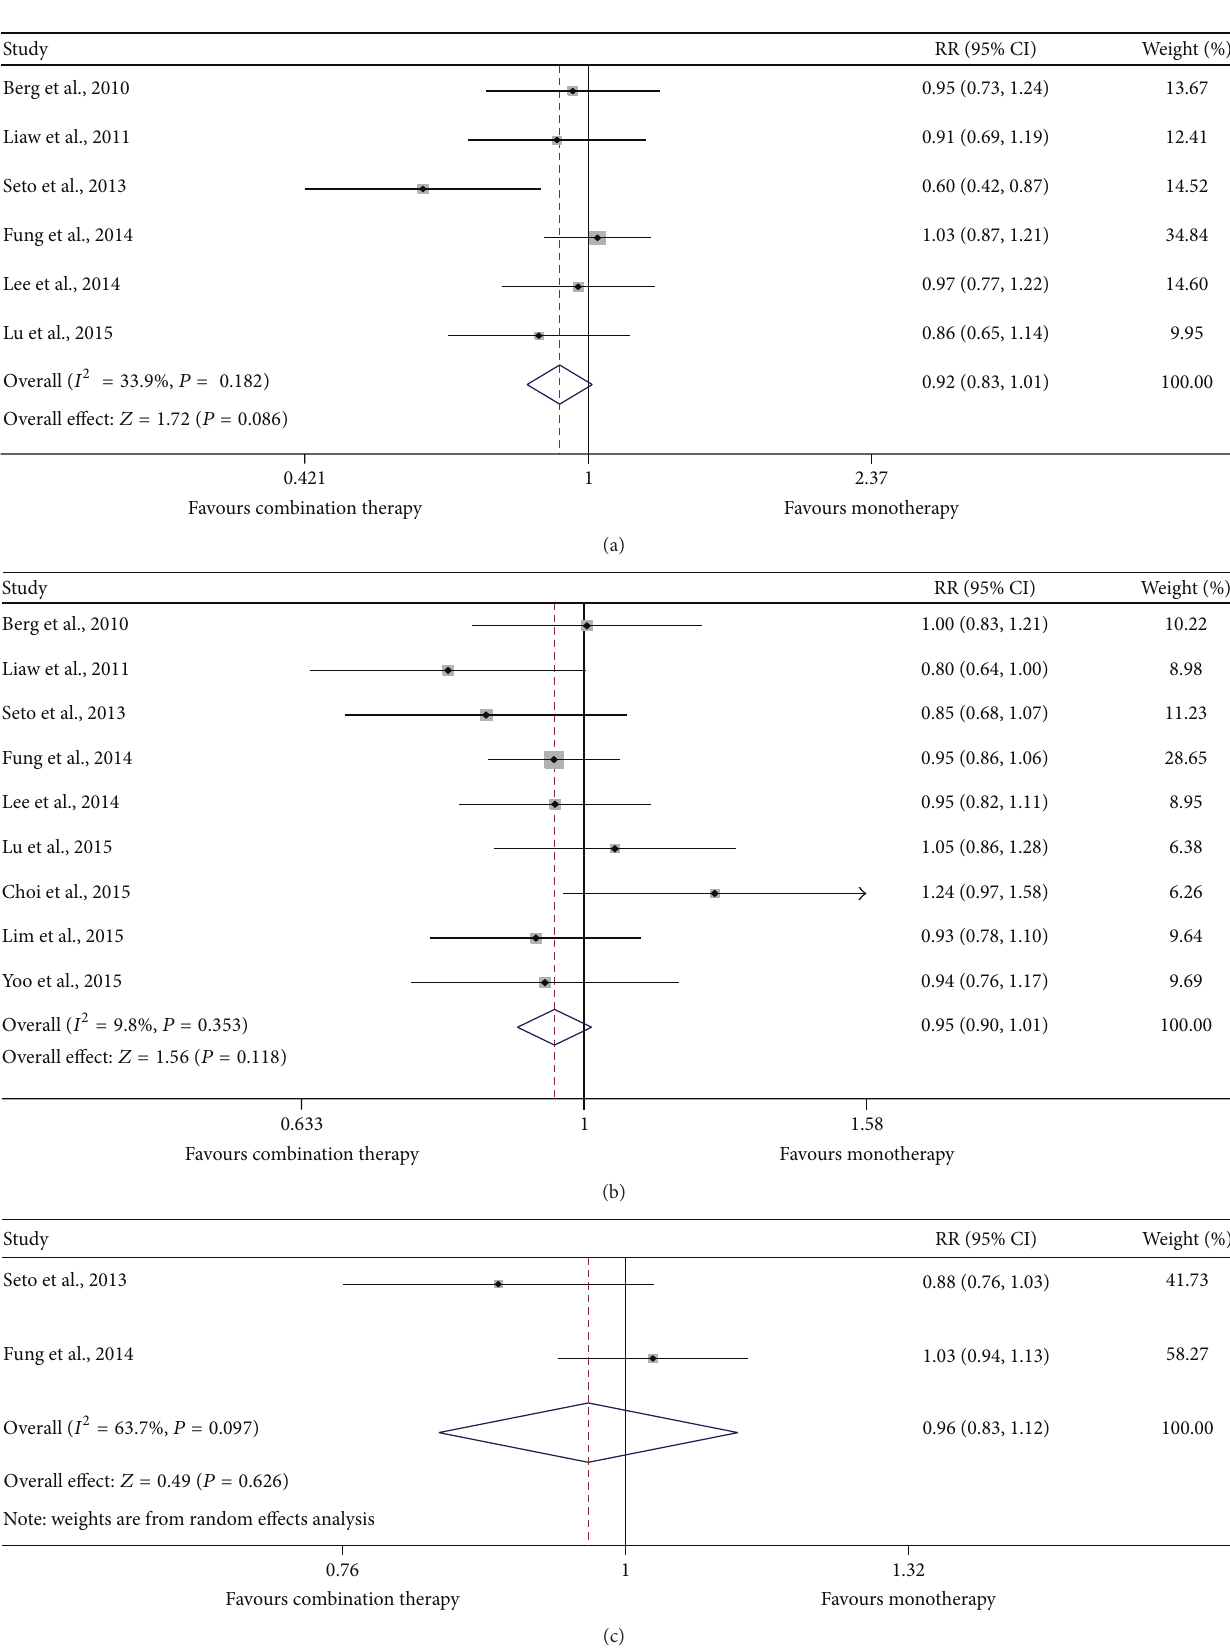
Figure 2: Forest map of summary estimates for comparison of virological suppression between TDF-based combination therapy and monotherapy groups. (a) 24 weeks; (b) 48 weeks; (c) 96